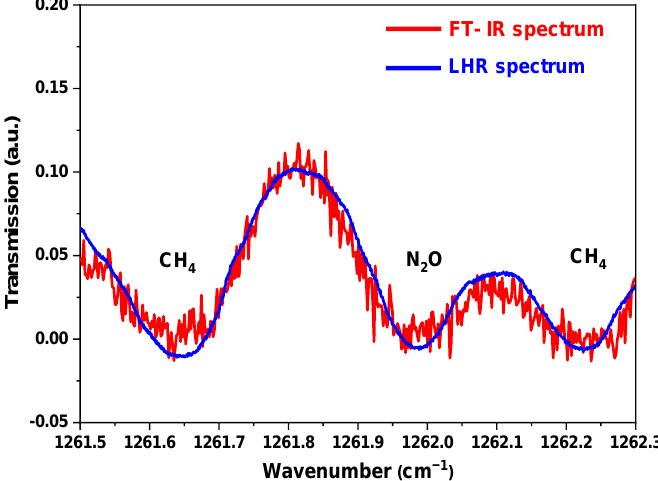
Figure 7. Atmospheric absorption spectrum of CH 4 and N 2 O recorded with a Bruker IFS 125HR Fourier-transform spectrometer (FTS) in Paris (in red ), with our LHR in Dunkerque (in blue ).